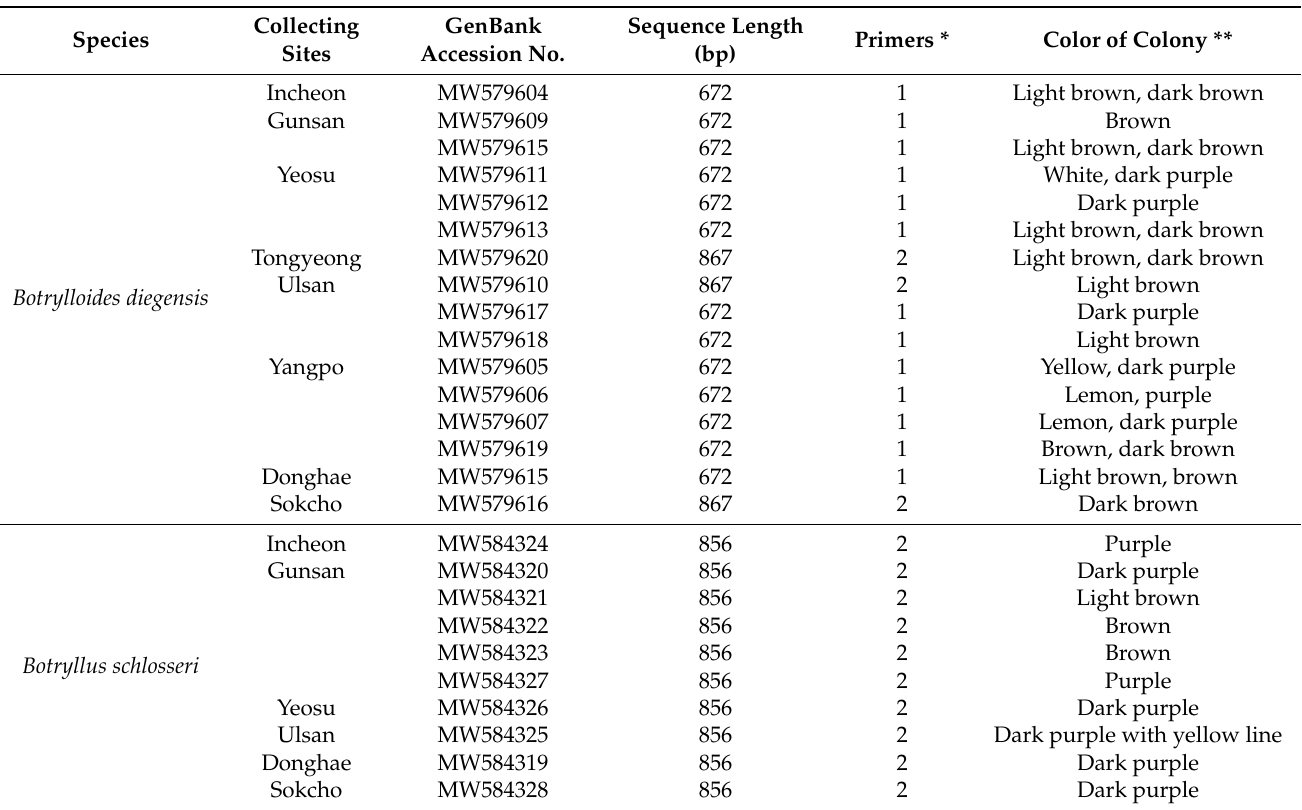
Table 2. GenBank accession number and sequencing information of Korean Botrylloides diegensis and Botryllus schlosseri used in this